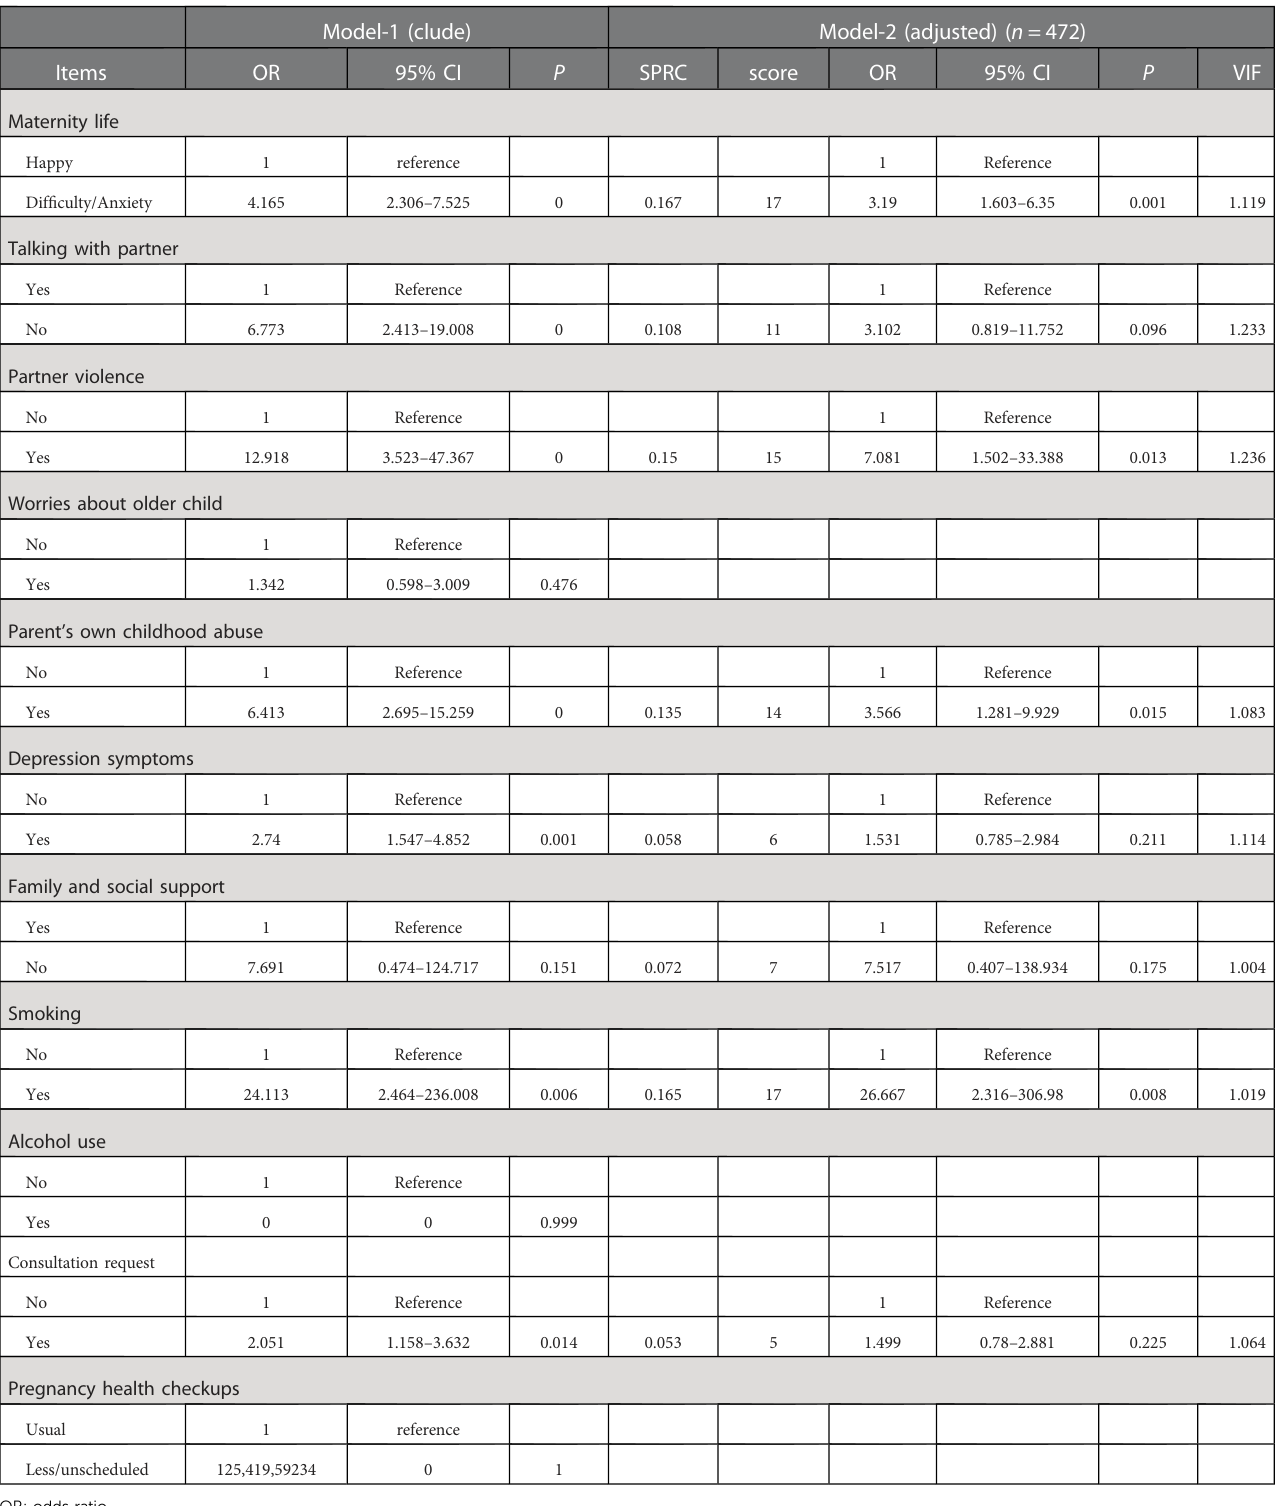
TABLE 4 The multiple linear regression analysis during the second trimester. Model-1